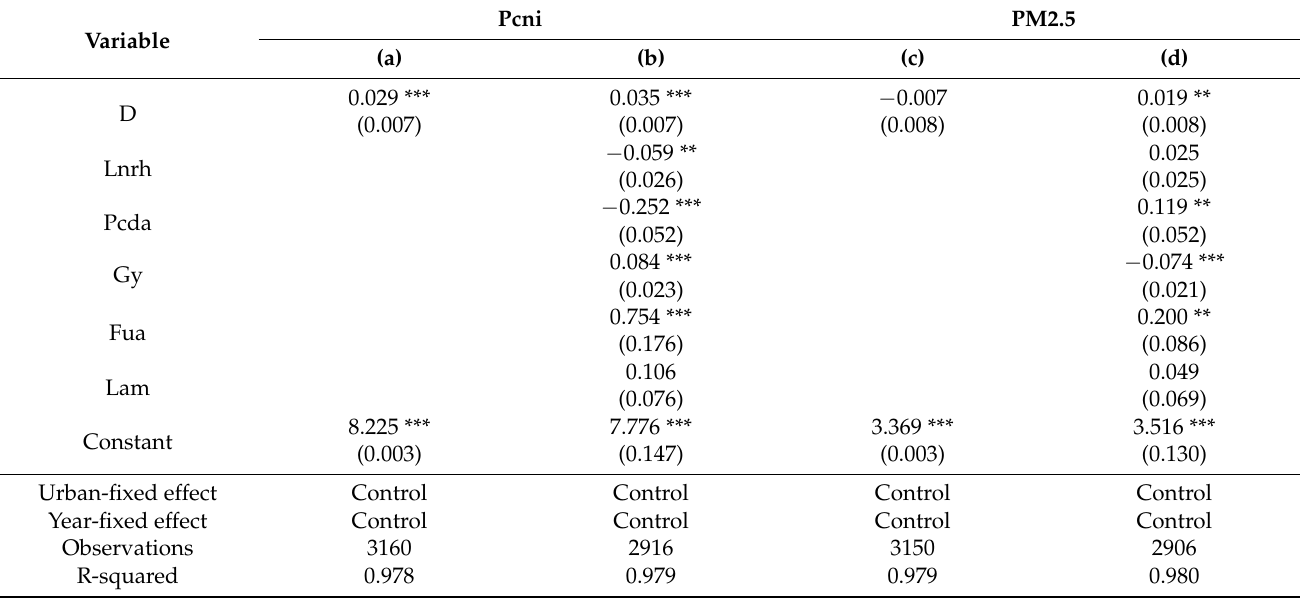
Table 2. Benchmark